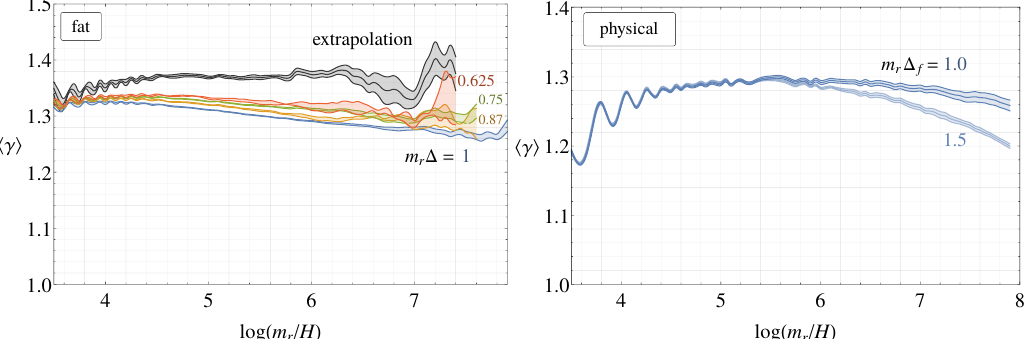
/ H ) for r ∆ indicated r f